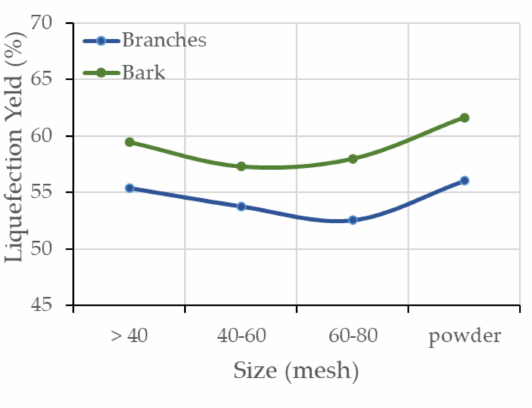
Figure 3. Effect of the bark and branches particle size to the liquefaction at 180 ◦ C for 60 min with acid